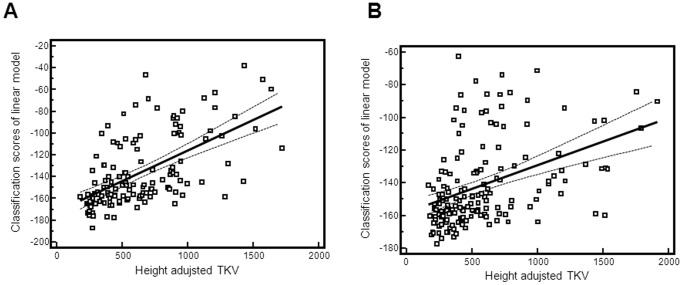
Scatter plots for correlation between classification scores of linear model for disease progression and the height adjusted TKV: Depicted are also the regression line and 95% confidences.In A training set data are showed and in B test set data.